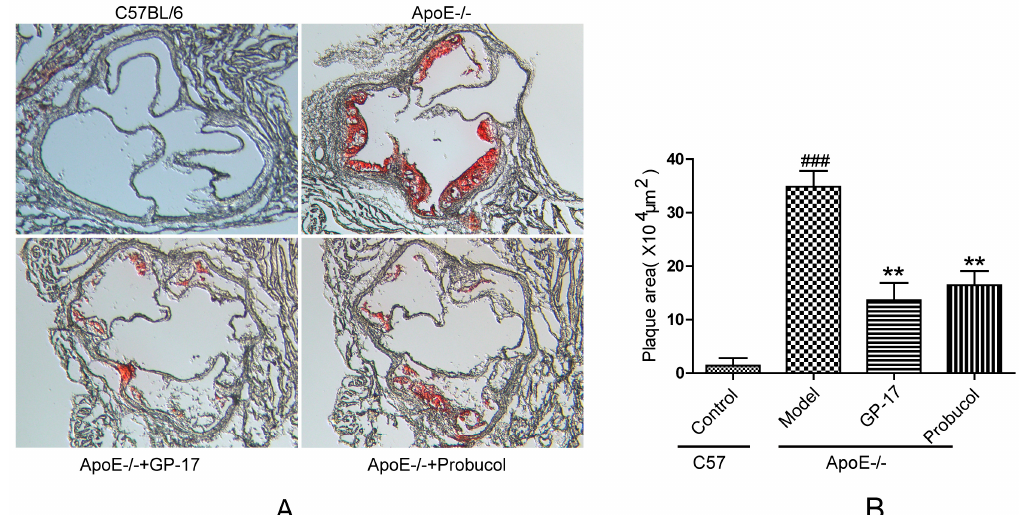
Figure 3. GP-17 effects on lipid deposition in the aortic sinus stained with oil red O. ( A ) Atherosclerotic lesion shown with oil red O staining; ( B ) Quantitative analysis of plaque areas in the aortic sinus by Image-Pro Plus software. Original magnification ( A ): ×200. The values are expressed as the mean ± S.E.M. ( n = 8 for each group). ### p < 0.001 vs. Control; ** p < 0.01 vs. Model.